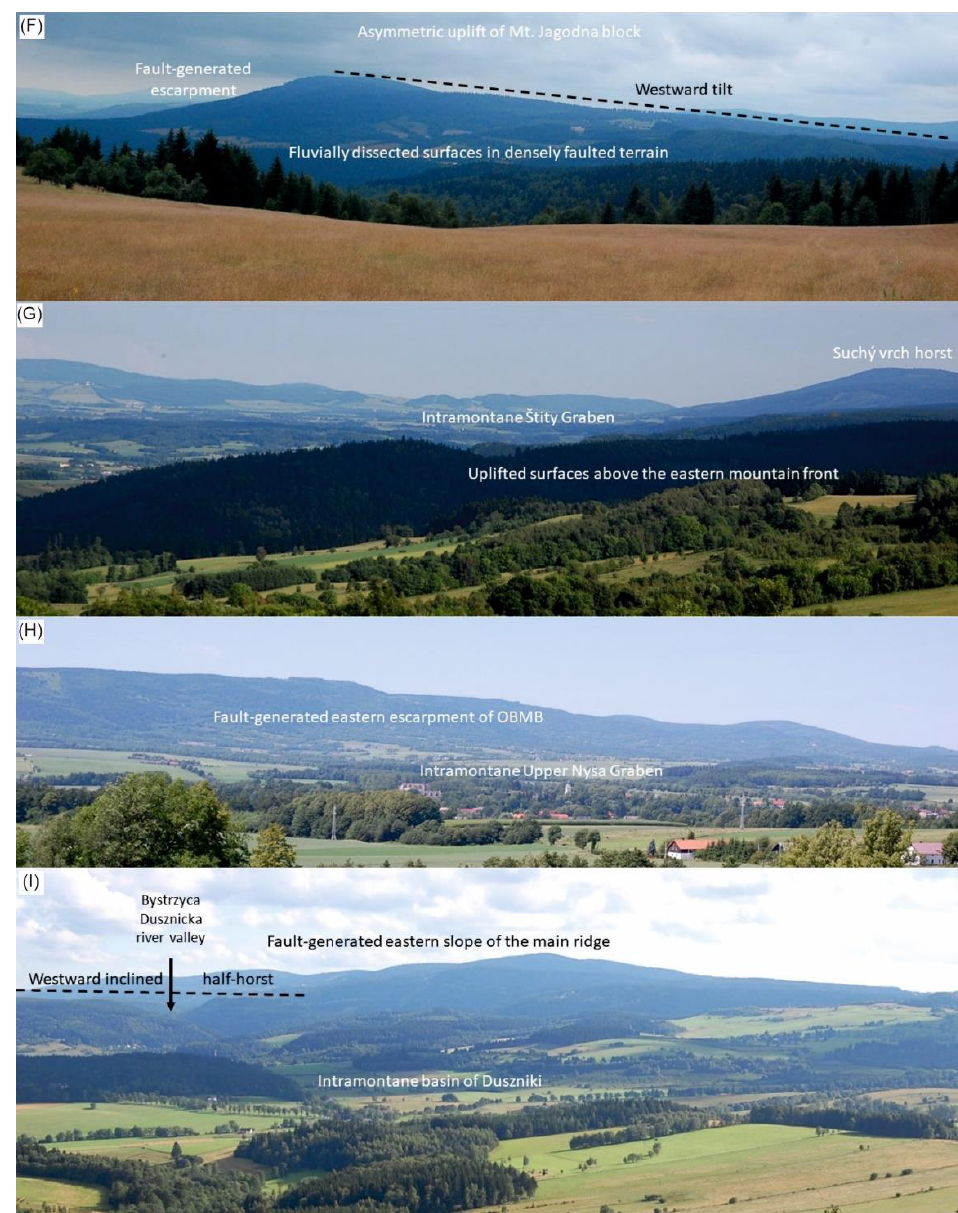
Figure 6. Panoramic viewpoints in the Orlické–Bystrzyckie Mountains Block, allowing the visitors to follow gross relief features attested to the long-term landform evolution of the area. Localities: ( A ) Liberk; ( B ) Dobrošov; ( C ) Polom; ( D ) Velká Deštná; ( E ) Mostowice; ( F ) Huta; ( G ) Jedlnik; ( H ) Mielnik; ( I ) Skały Puchacza. Location of viewpoints on Figure 5.